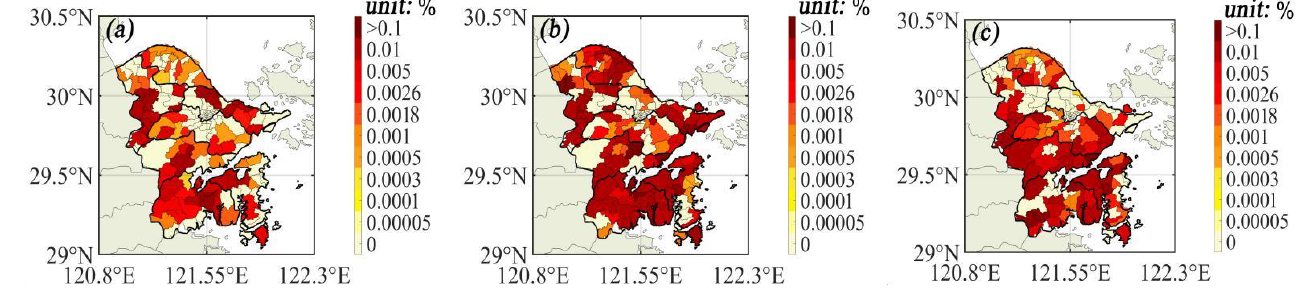
Figure 6. Insured loss rate of townships due to type I typhoons. ( a ) 1416 Fung-wong; ( b ) 1509 Chan-hom; ( c ) 1909 Lekima.